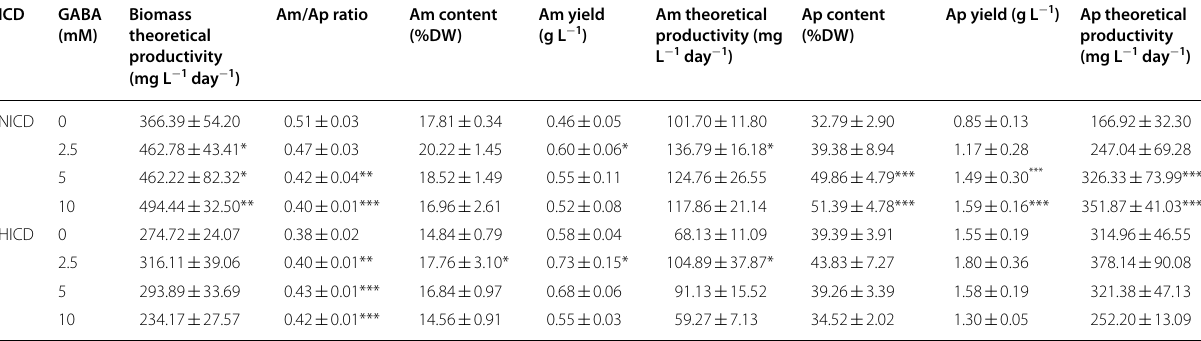
*, **, and *** denote the significant differences at p < 0.1, p < 0.05, and p < 0.01 levels, respectively, under different GABA conditions (2.5–10 mM) compared to those under 0 mM GABA (means SD, n 3) ± =